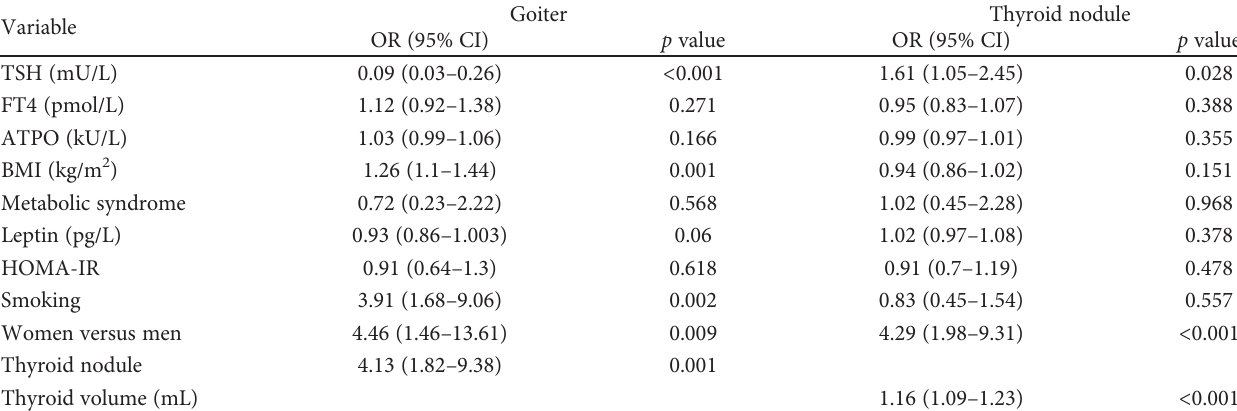
Table 3: Multivariate analysis of associations of goiter and thyroid nodules with analyzed